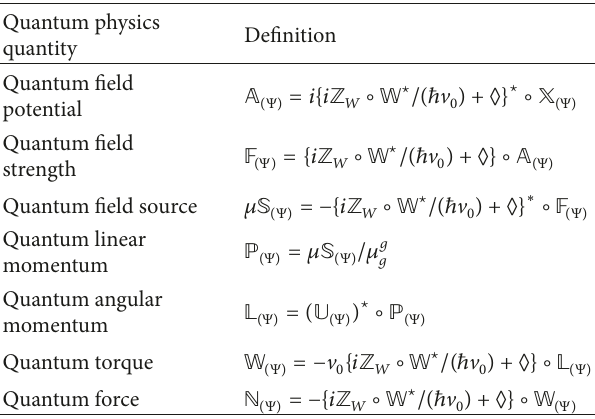
Table 4: Some field equations of the quantum mechanics in the complex-sedenion